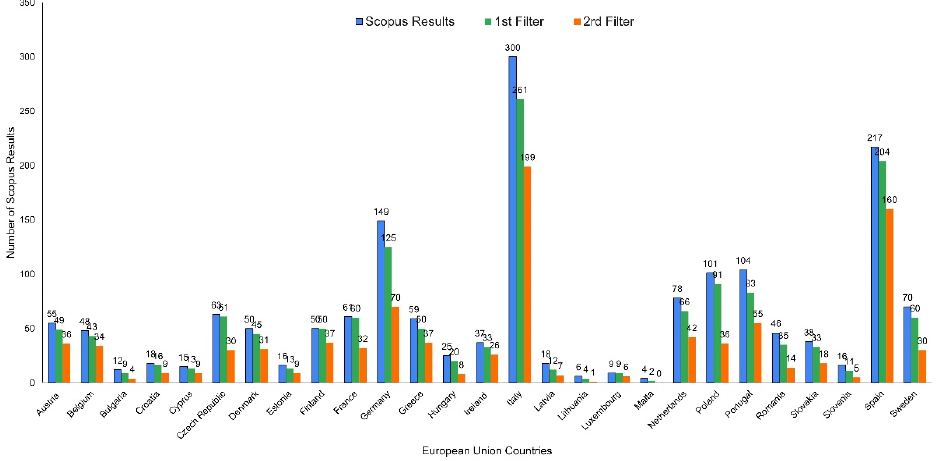
Figure 2. Number of Scopus results per European Union country after applying exclusion criteria.